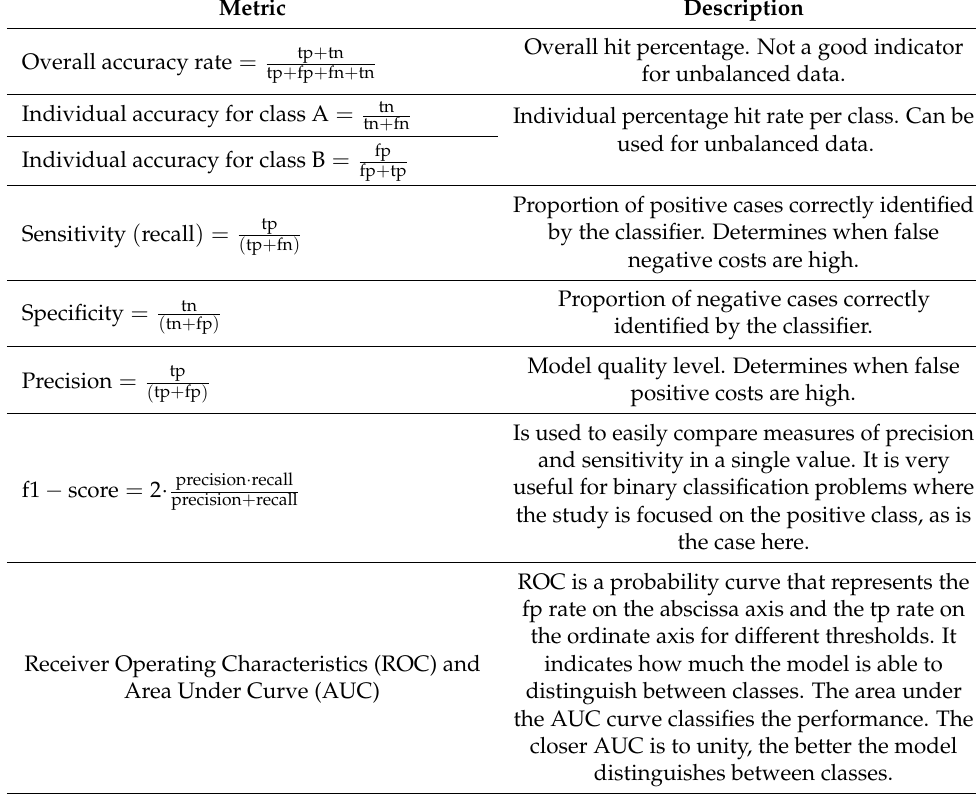
Table 10. Performance evaluation metrics for a classification